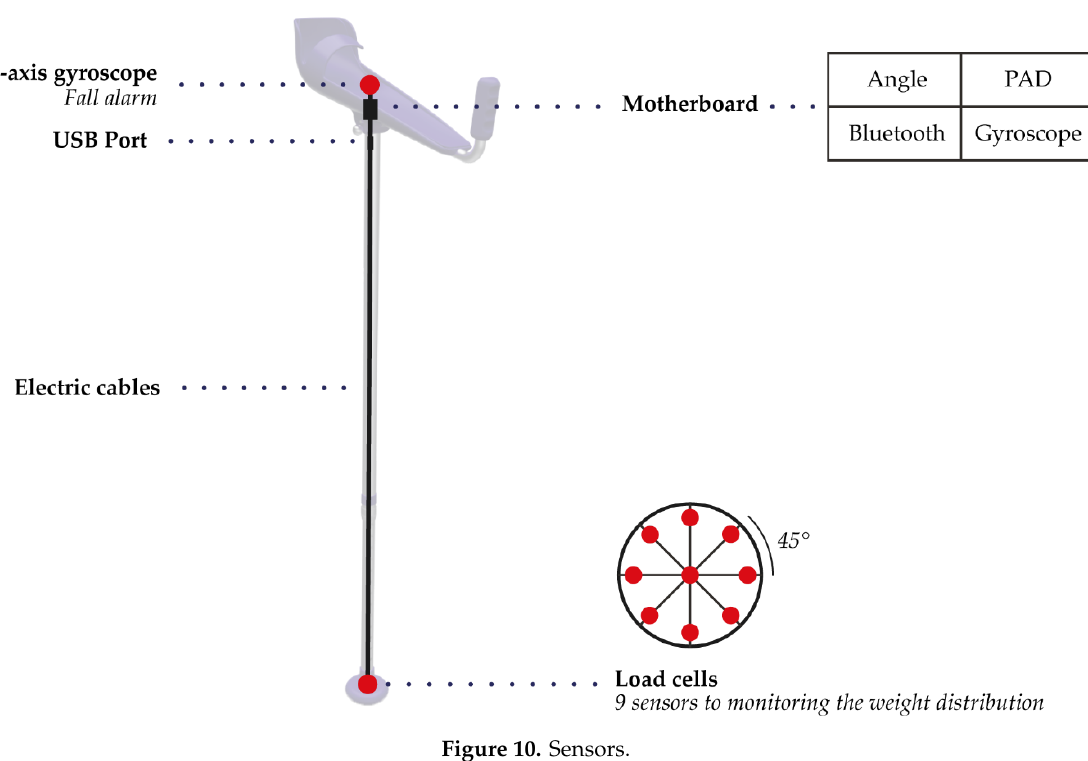
Figure 11. Information tree.